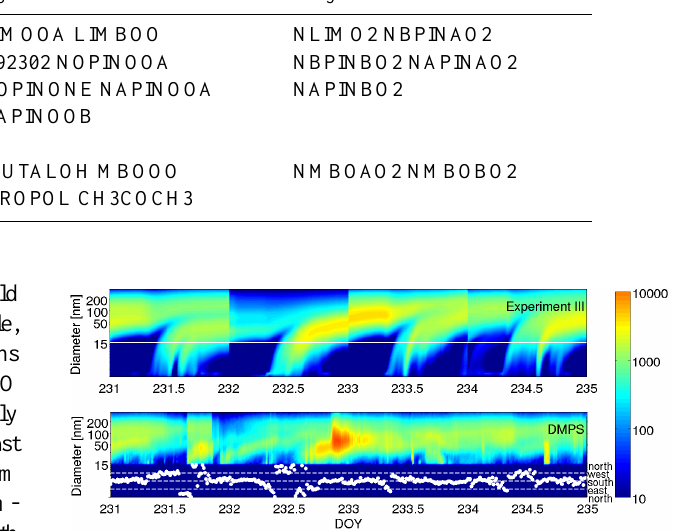
Figure 10. Particle number size distribution from 19 August 2010 (DOY 231) to 22 August 2010 (DOY 234) based on the model ex- periment III (top) and DMPS measurements (bottom). The DMPS instrument has a 15nm lower detection limit. Particle concentra- tion units: moleculescm − 3 . Observation of wind direction at 30m is plotted as white dots in the lower portion of the bottom figure.